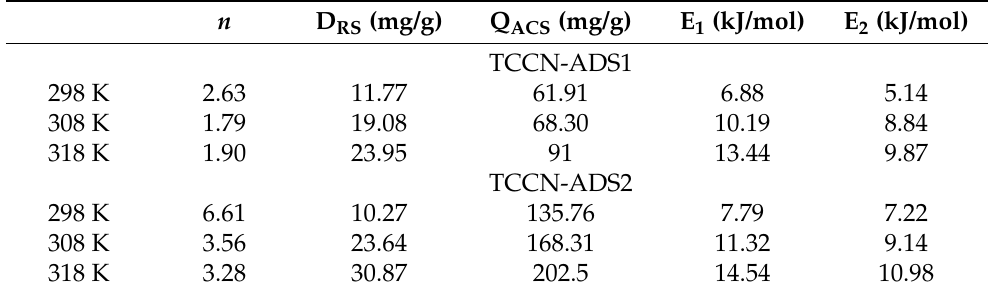
Table 1. Double layer (M2) model parameters as a function of temperature (T = 298, 308 and 318